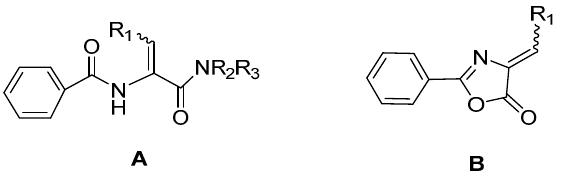
Figure 2. Structure of benzamides A and 4-substituted-2-phenyloxazol-5(4 H )-ones B .